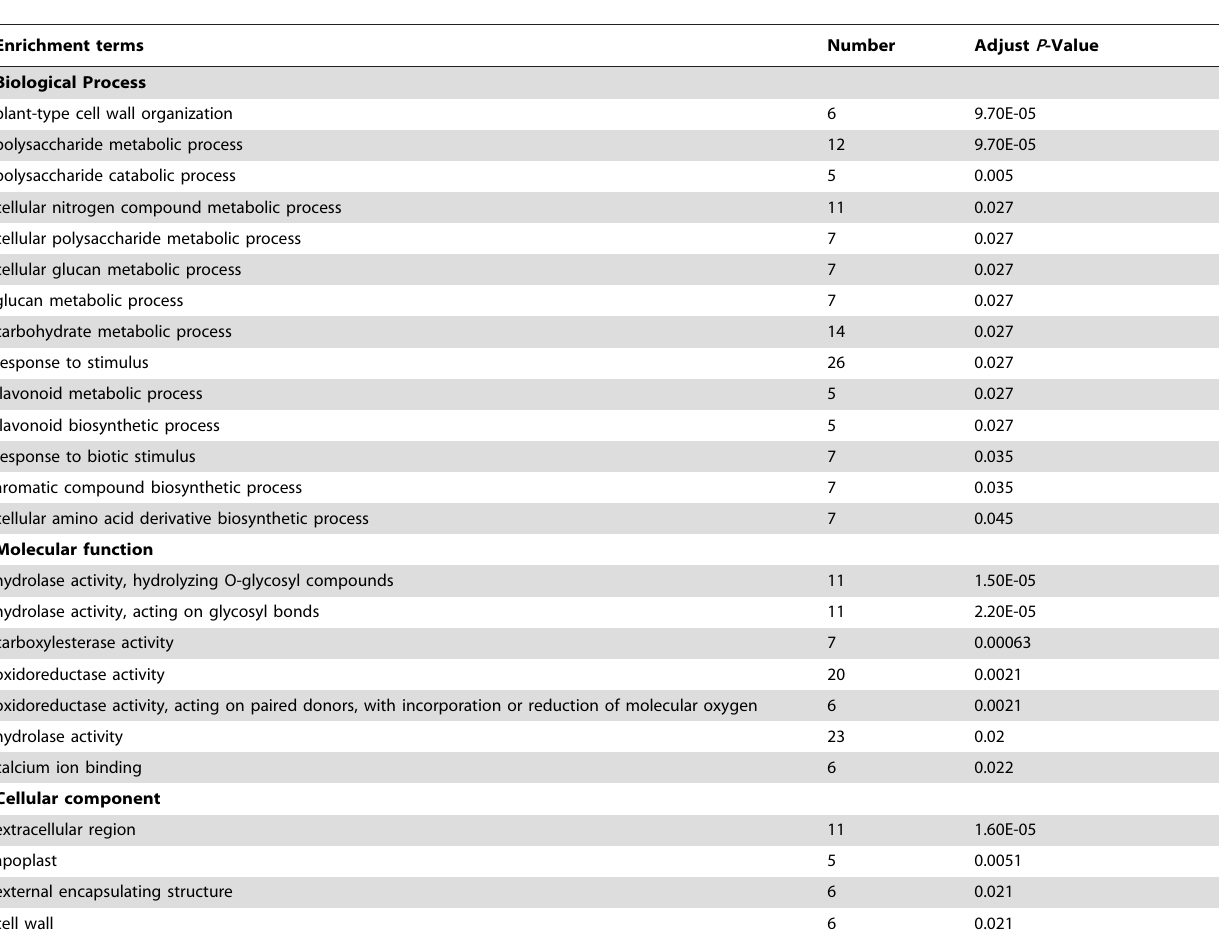
Table 1. Significantly enriched GO terms (adjust P , 0.05) of common upregulated genes in ‘Meiwa’ and ‘Newhall’ after Singular Enrichment